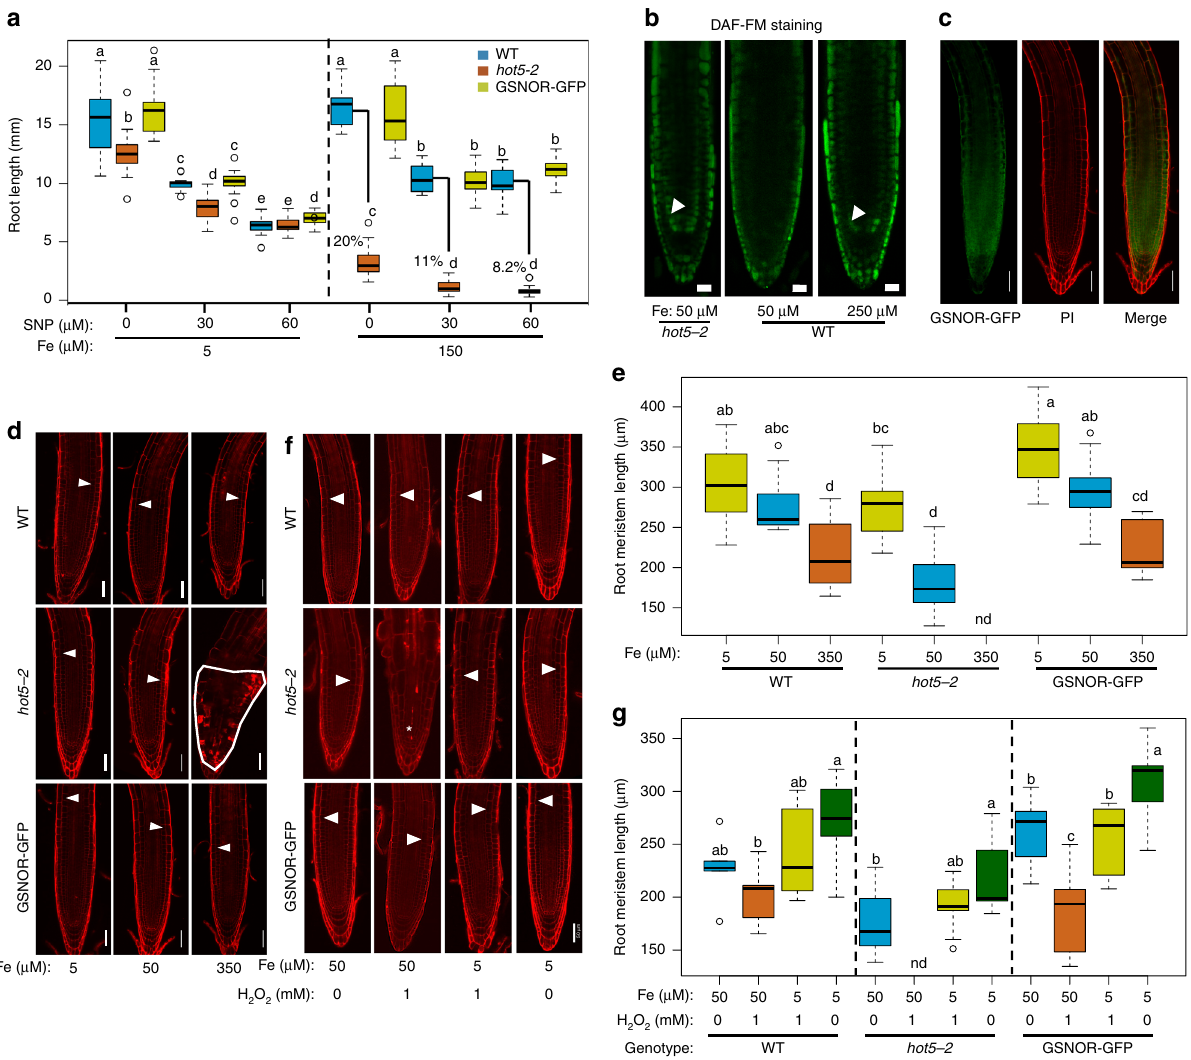
Fig. 6 GSNOR alleviates Fe-dependent NO and H 2 O 2 toxicities to promote root meristem growth. a Box plots for root growth upon high Fe and nitric oxide (NO) donor (sodium nitroprusside, SNP) at day 7 ( n = 16 biologically independent samples). Root length of hot5-2 relative to WT is shown in the right panel. b Fluorescence signal of root NO stained with DAF-FM at day 6. White arrows denote cortex cells in meristems. c Fluorescence signal of root expressing pGSNOR:GSNOR-GFP at day 6 under control conditions. d Root meristems stained by propidium iodide (PI) at day 6. e Box plots for root meristem of experiments depicted in ( d ) ( n = 10 biologically independent samples). f Root meristems stained by PI upon H 2 O 2 and Fe treatments at 7 days. White arrows indicate the border of elongation zone, while region outlined in white line and asterisk indicates cell death in the root meristem ( d , f ). g Box plots for root meristem length of experiments depicted in ( f ) ( n = 9 biologically independent samples). Different letters indicate the signi fi cant differences according to Tukey ’ s HSD test ( p < 0.05) between genotypes or different conditions in a given genotype. nd denotes not detected. Scale bar: 20 µ m in ( b ); 50 µ m in ( c , d and f ). The Source data of Fig. 6a, e, and g are provided in a Source Data fi